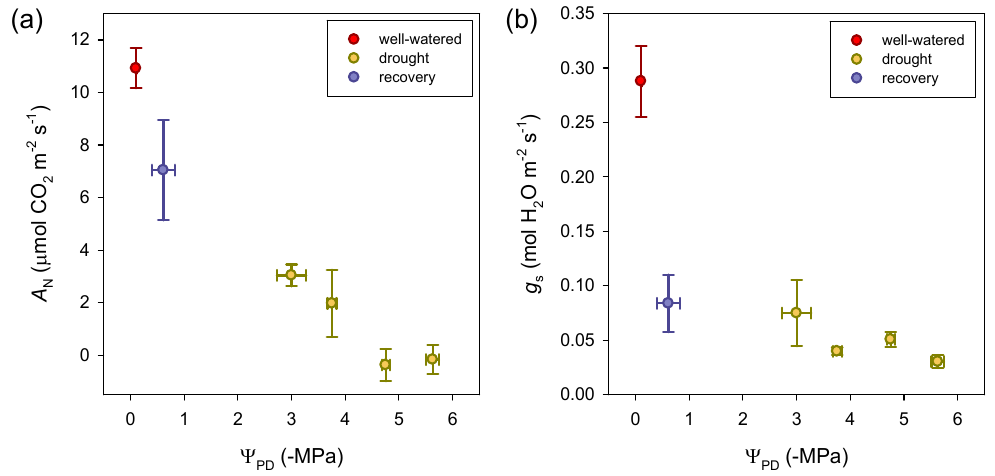
Figure 2. Time course of ( a ) net photosynthesis ( A N ) and ( b ) stomatal conductance ( g s ) with predawn water potential ( ψ PD ) for holm oak leaves well ‐ watered (red symbols), during the drought period (yellow symbols) and 7 days after plants were re ‐ watered (violet symbols). Data are mean ± SE.